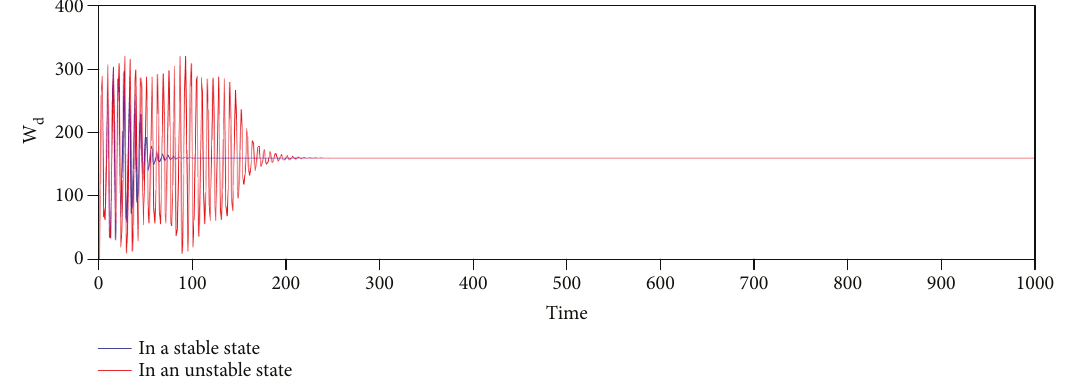
Figure 15: Comparison of tra ffi c volume changes by third-party logistics service providers in a stable state and unstable state under fi xed constant demand.